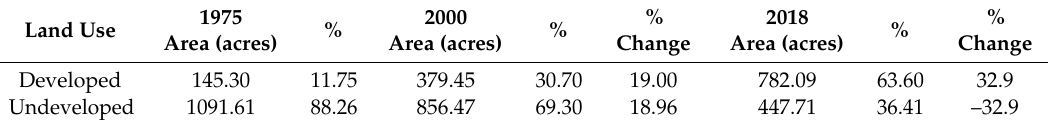
Table 3. Proportion of undeveloped and developed land in Trede (source: Field survey, 2018). Land